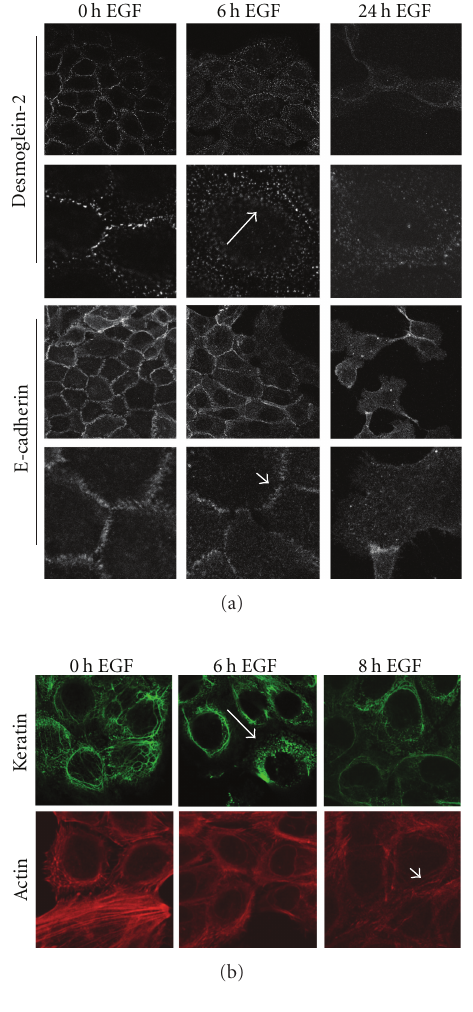
Figure 4: Di ff erent kinetics for disruption of desmosomes and adherens junctions by EGF. (a) SCC 12F cells were treated with EGF for the indicated times, fixed, and then probed with E- cadherin or desmoglein-2 antibodies. Note the relocalization of the desmosomal cadherin desmoglein-2 from the cell borders following treatment with EGF for 4–6h (white arrows). This pattern di ff ers from that observed for the adherens junctional cadherin, E- cadherin, where strong border staining is evident at 6 hours post EGF treatment (white arrowheads). (b) Cells were treated with EGF, fixed, and then stained with phalloidin to stain the actin cytoskeleton, or with a pan-cytokeratin antibody, to label keratin filaments. Disorganization of the keratin network is seen at 6 hours (white arrow), while the actin cytoskeleton remains intact at 8 hours posttreatment (white arrowheads).